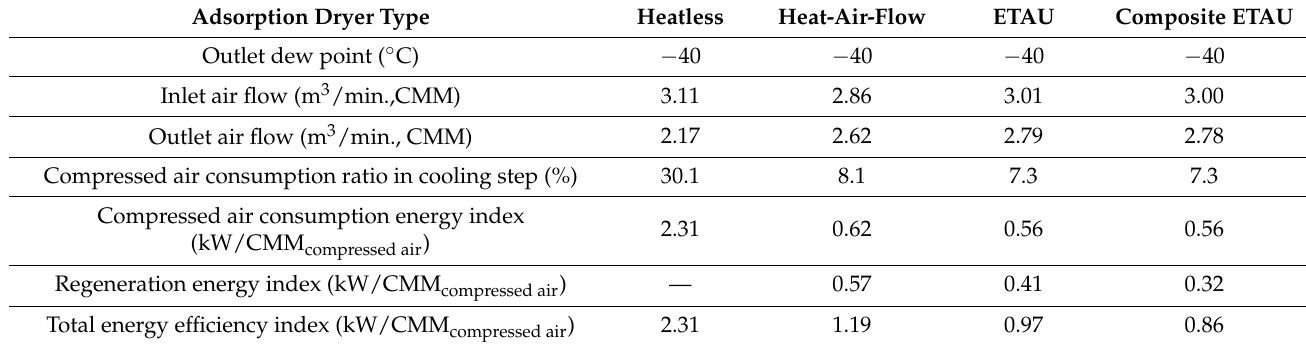
Table 6. Performance of a commercial adsorption dryer and the proposed ETAU system. Adsorption Dryer